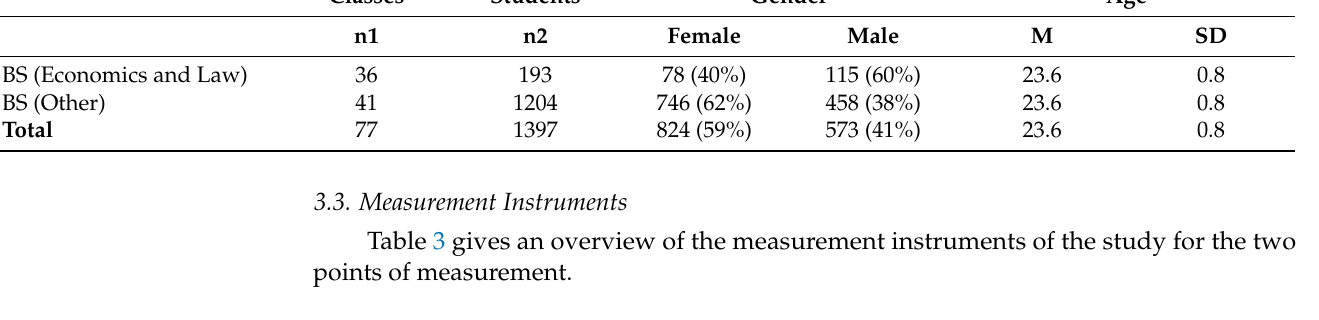
Table 3. Measurement